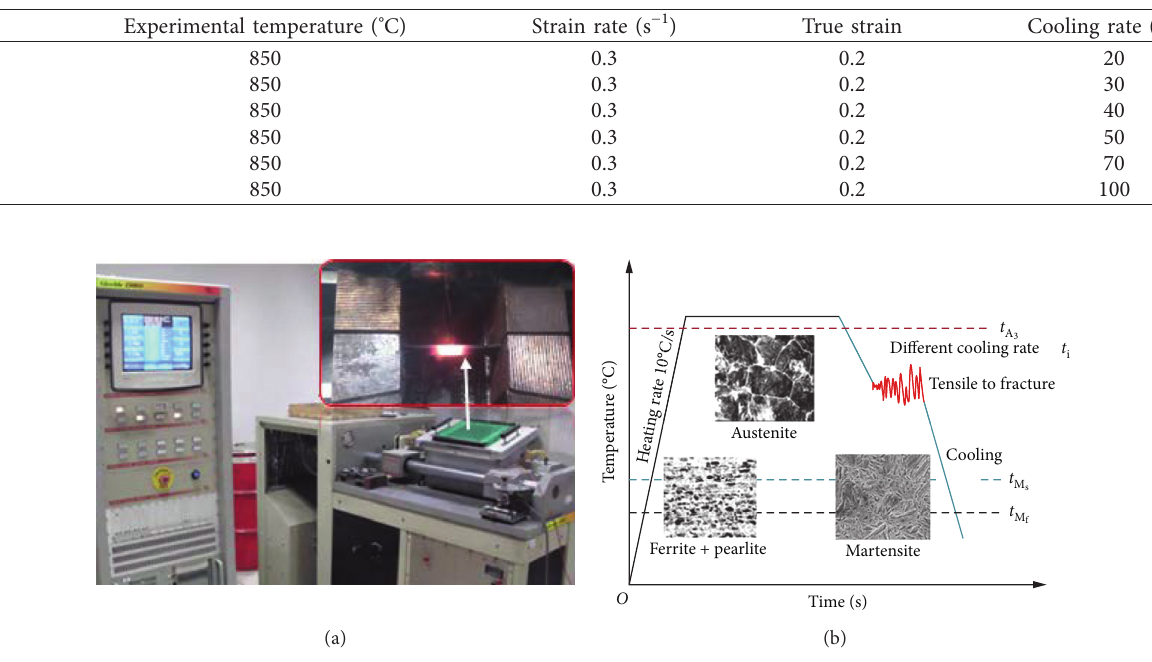
Table 2: Specimen of experiment design.